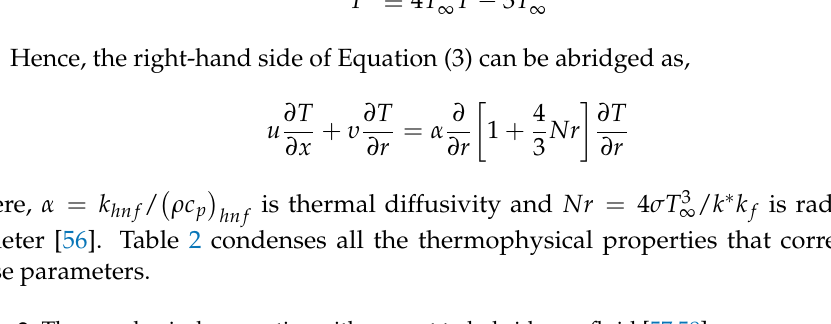
Table 2. Thermophysical properties with respect to hybrid nanofluid [57,58]. Thermophysical Hybrid